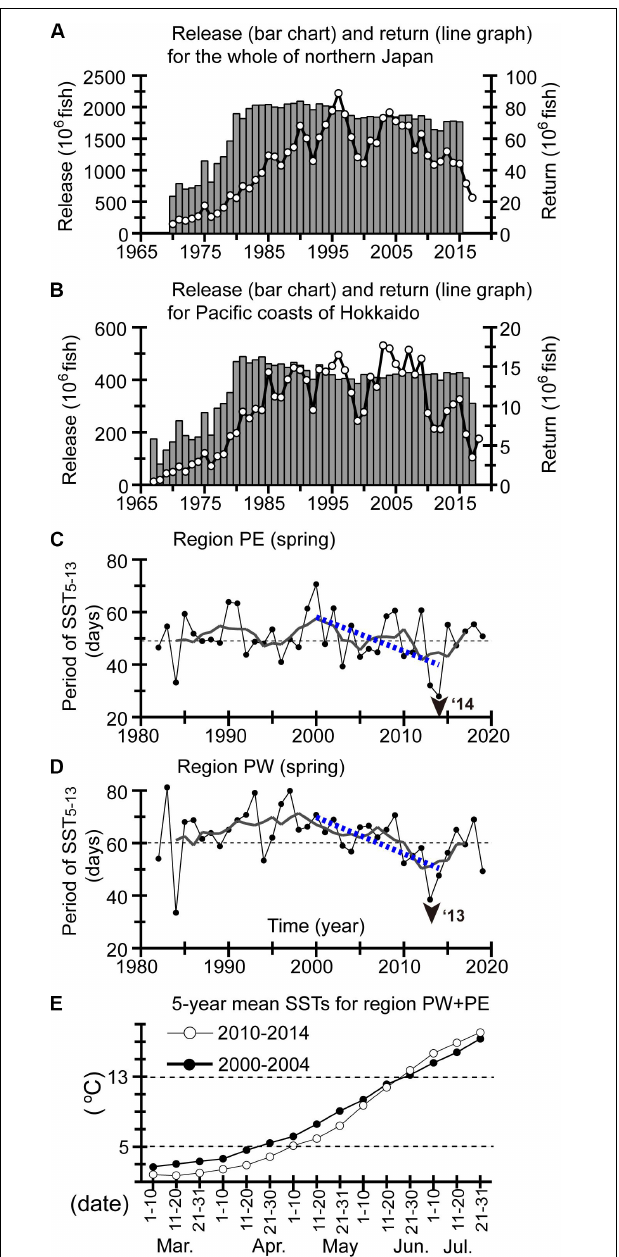
FIGURE 8 | (A) The number of Japanese chum salmon released (bar chart) and adult returns (line graph) for all of Japan. (B) The same as (A) , but for Pacific waters around Hokkaido ( Figure 6B ). The duration of periods with SSTs of 5–13 ◦ C in spring for regions (C) PW and (D) PE. Display style in panels (C,D) are the same as in Figure 5 . (E) SSTs in regions PW and PE over intervals of about 10 days were averaged for 2000–2004 (closed circles) and 2010–2014 (open